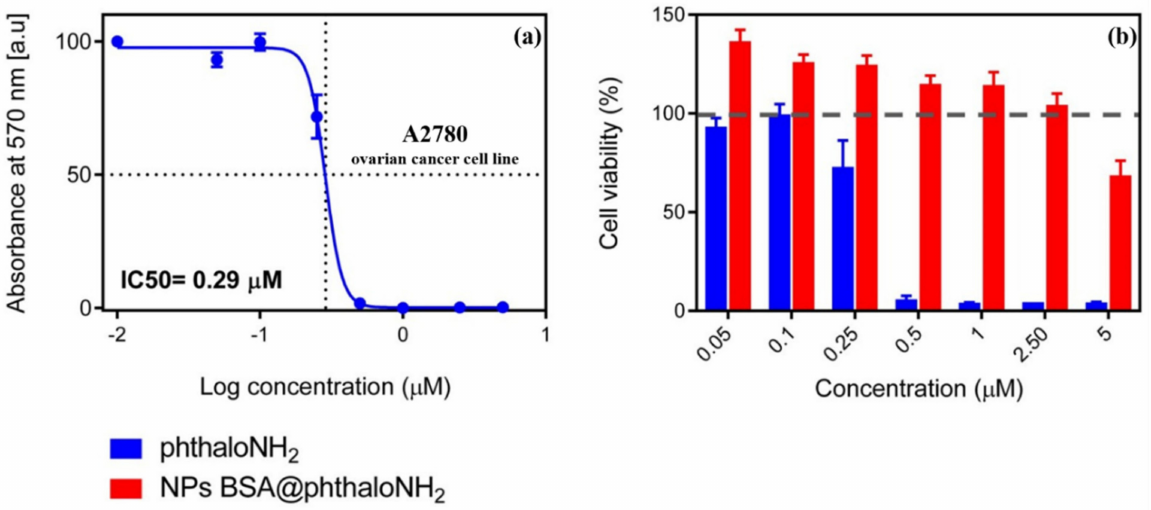
Figure 6. MTT cells assay; ( a ) survival curve of A2780 cells treated with phthaloNH 2 —nonlinear regression; and four- parameter sigmoidal curve fit, each point representing mean ± SEM in three separate measurements; dose-dependent decrease of the viability of A2780 cells treated with phtaloNH 2 ; ( b ) comparison of the viability of ovarian cancer cells treated with phthaloNH 2 vs. BSA&phthaloNH 2